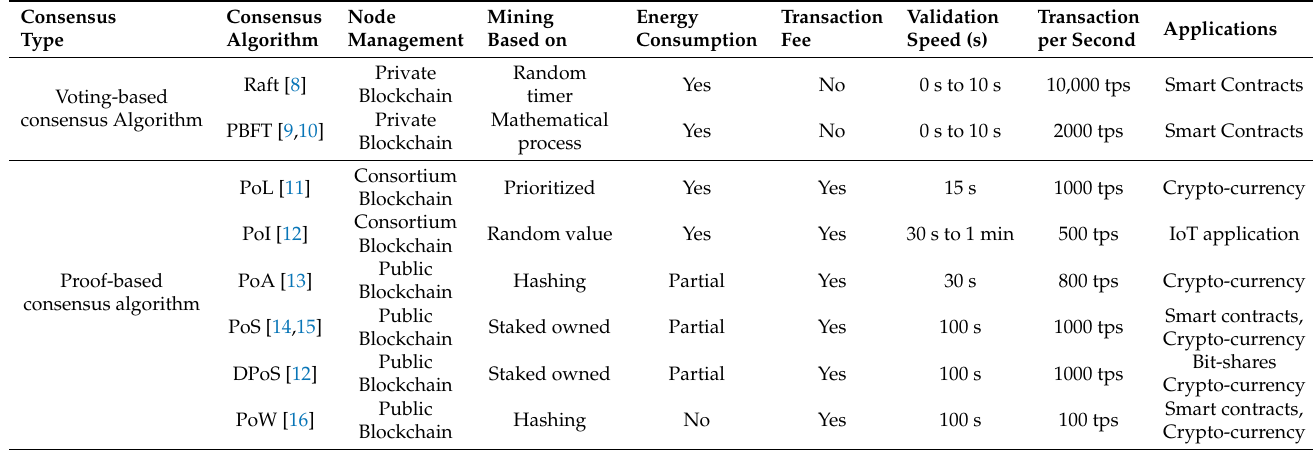
Table 1. Comparison of Blockchain complexity based on the consensus